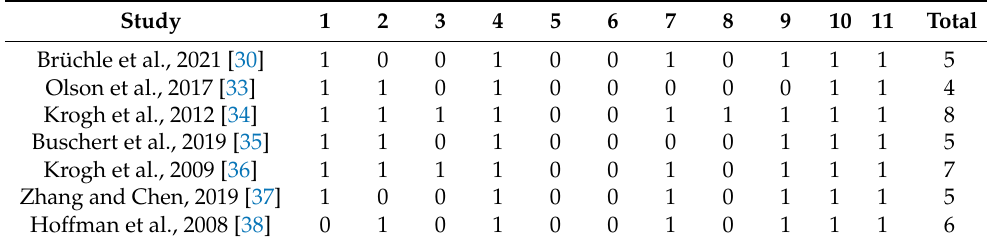
Table 4. PEDro scale of the studies included.